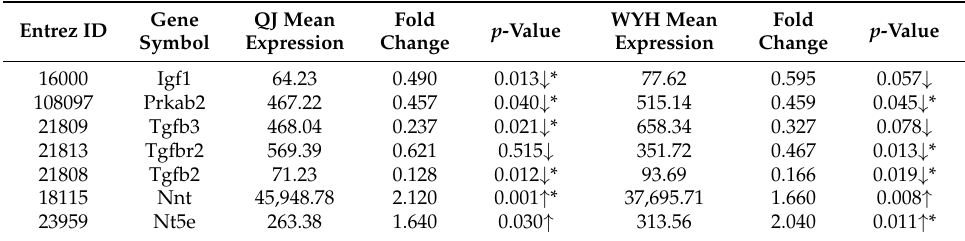
Table 2. The differentially expressed genes of the decomposed recipes (QJ and WYH) in the heart failure-related